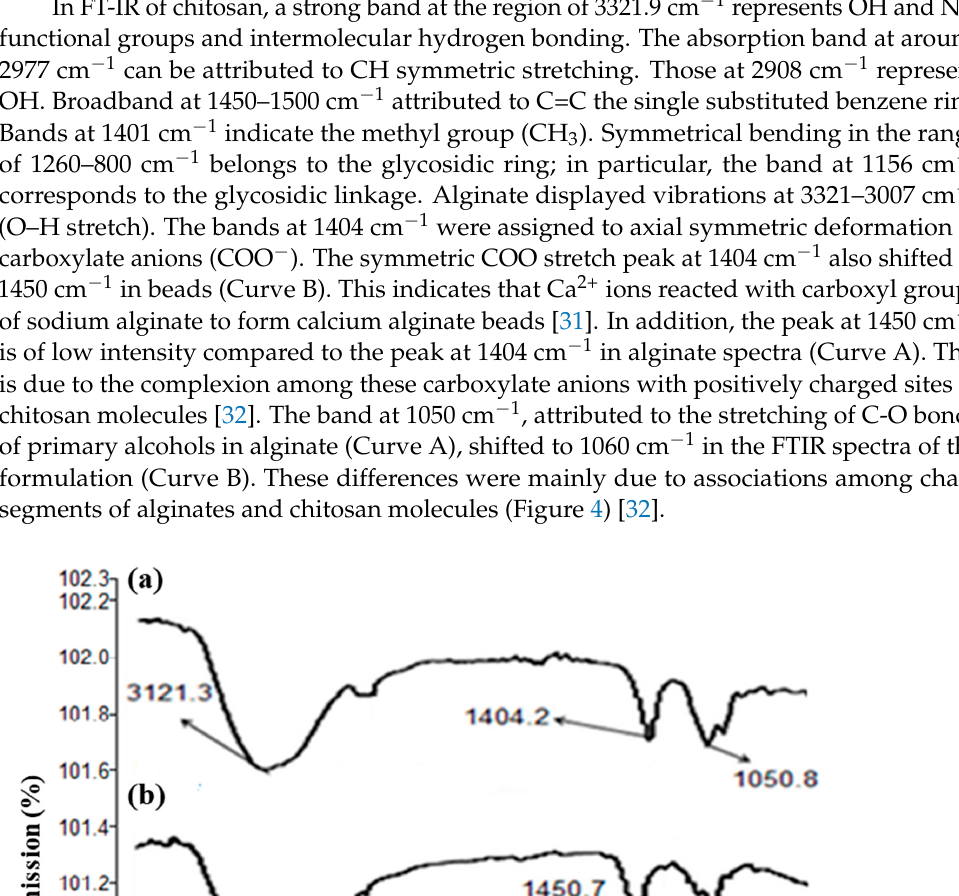
Figure 3. Schematic diagram representing ( A ) freshly prepared beads before drying, ( B ) freeze-dried beads, and ( C ) oven-dried beads.